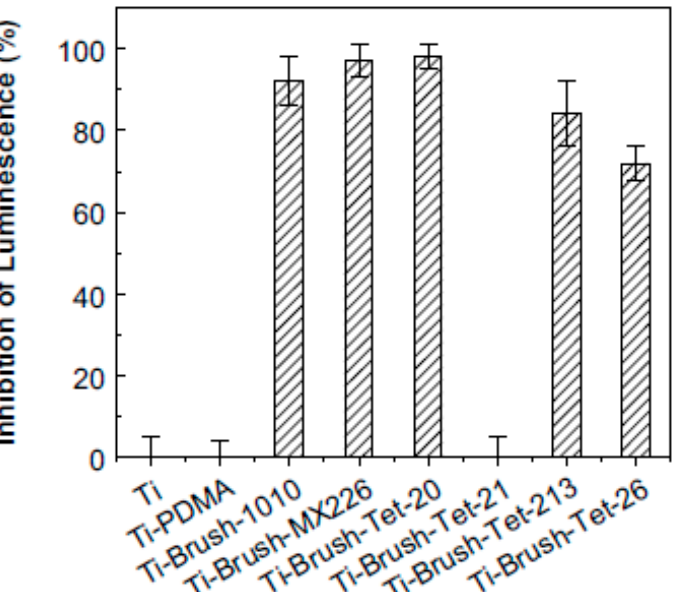
Figure 11. Antimicrobial activity of surface-immobilized peptides. Inhibition of luminescence of P. Aeruginosa upon incubation with titanium slides modified with peptide immobilized copolymer brush (surface area: 1 cm 2 ); inhibition of luminescence is taken as a measure of antimicrobial activity. Ti-slides and polydimethylacrylamide (PDMA) brush coated Ti-slides (neutral brushes) were used as controls. Reproduced with permission from [75]. Copyright 2011 American Chemical Society.